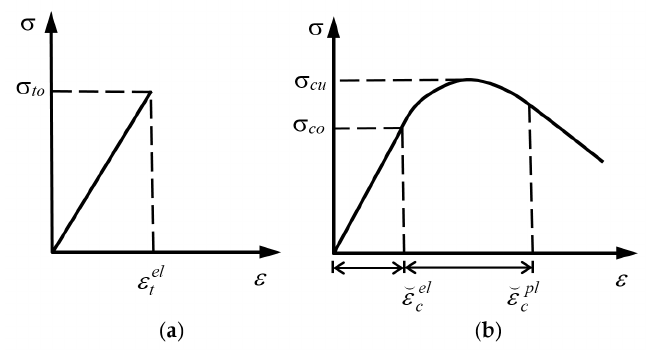
Figure 2. CDP model response to uniaxial loading in ( a ) tension and ( b ) compression [21,31].